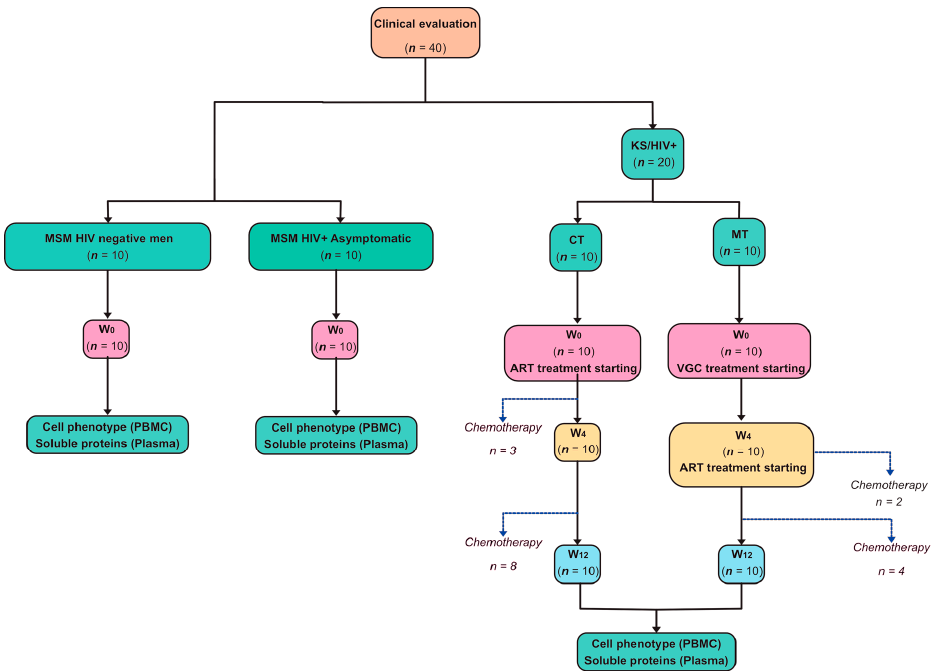
Figure 2. Workflow of KS/HIV patients recruitment and follow-up. A total of 40 participants were enrolled, 20 with KS/HIV diagnostic, 10 HIV+ asymptomatic, and 10 HIV-MSM (Men who have Sex with Men). The KS/HIV group was divided according to the received scheme treatment; 10 KS/HIV patients received the conventional treatment scheme (CT = ART) since baseline (W 0 ), and 10 KS/HIV patients received the modified treatment scheme (MT = VGC + ART) starting with VGC at W 0 and ART at W 4 . The blue line shows the number of patients that received chemotherapy across follow- up. Cell phenotype using peripheral mononuclear cells (PBMC) and soluble proteins in plasma were evaluated on KS/HIV groups at W 0 and follow-up at W 4 and W 12 . In addition, the HIV+ asymptomatic men and HIV negative MSM groups were evaluated at W 0 . The number of samples processed per group for each experimental protocol is shown in parentheses.